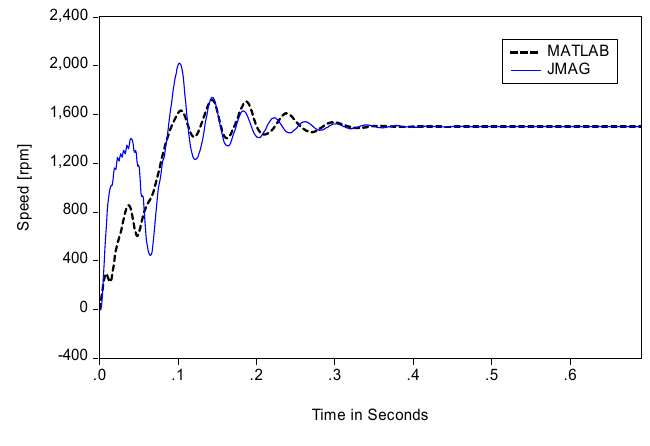
Figure 9. Speed at 1.5 N ∙ m load.